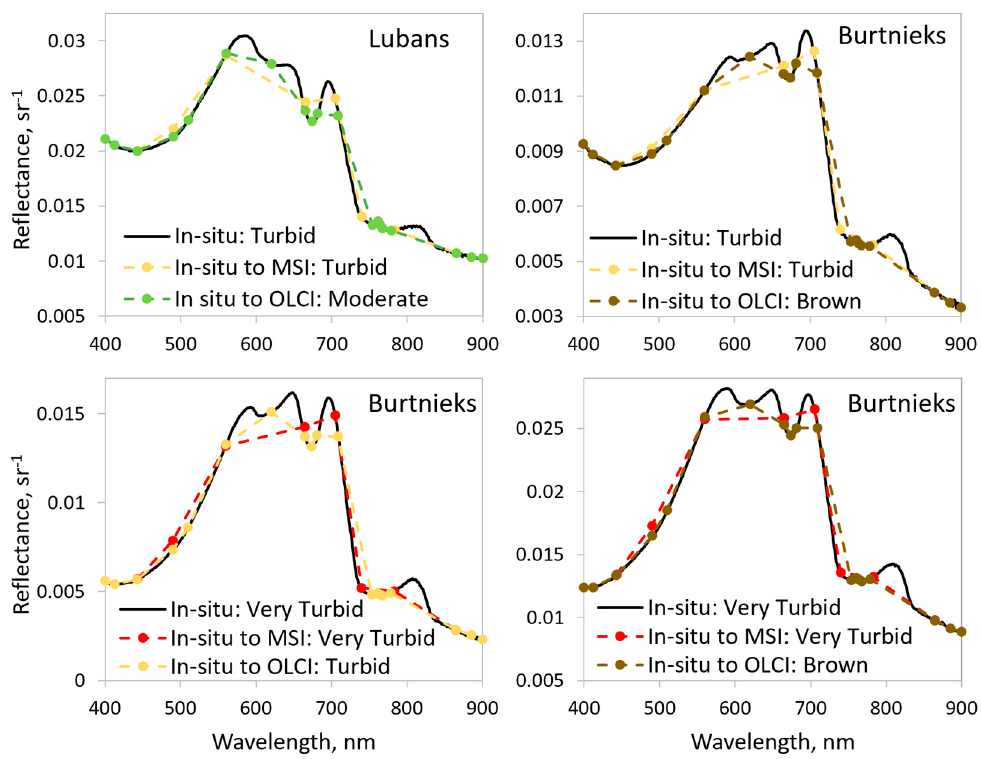
Figure 3. Four examples of obtaining different optical water types (OWTs) from in-situ hyperspectral reflectance spectra calculated to MSI and OLCI bands using specific spectral response functions.